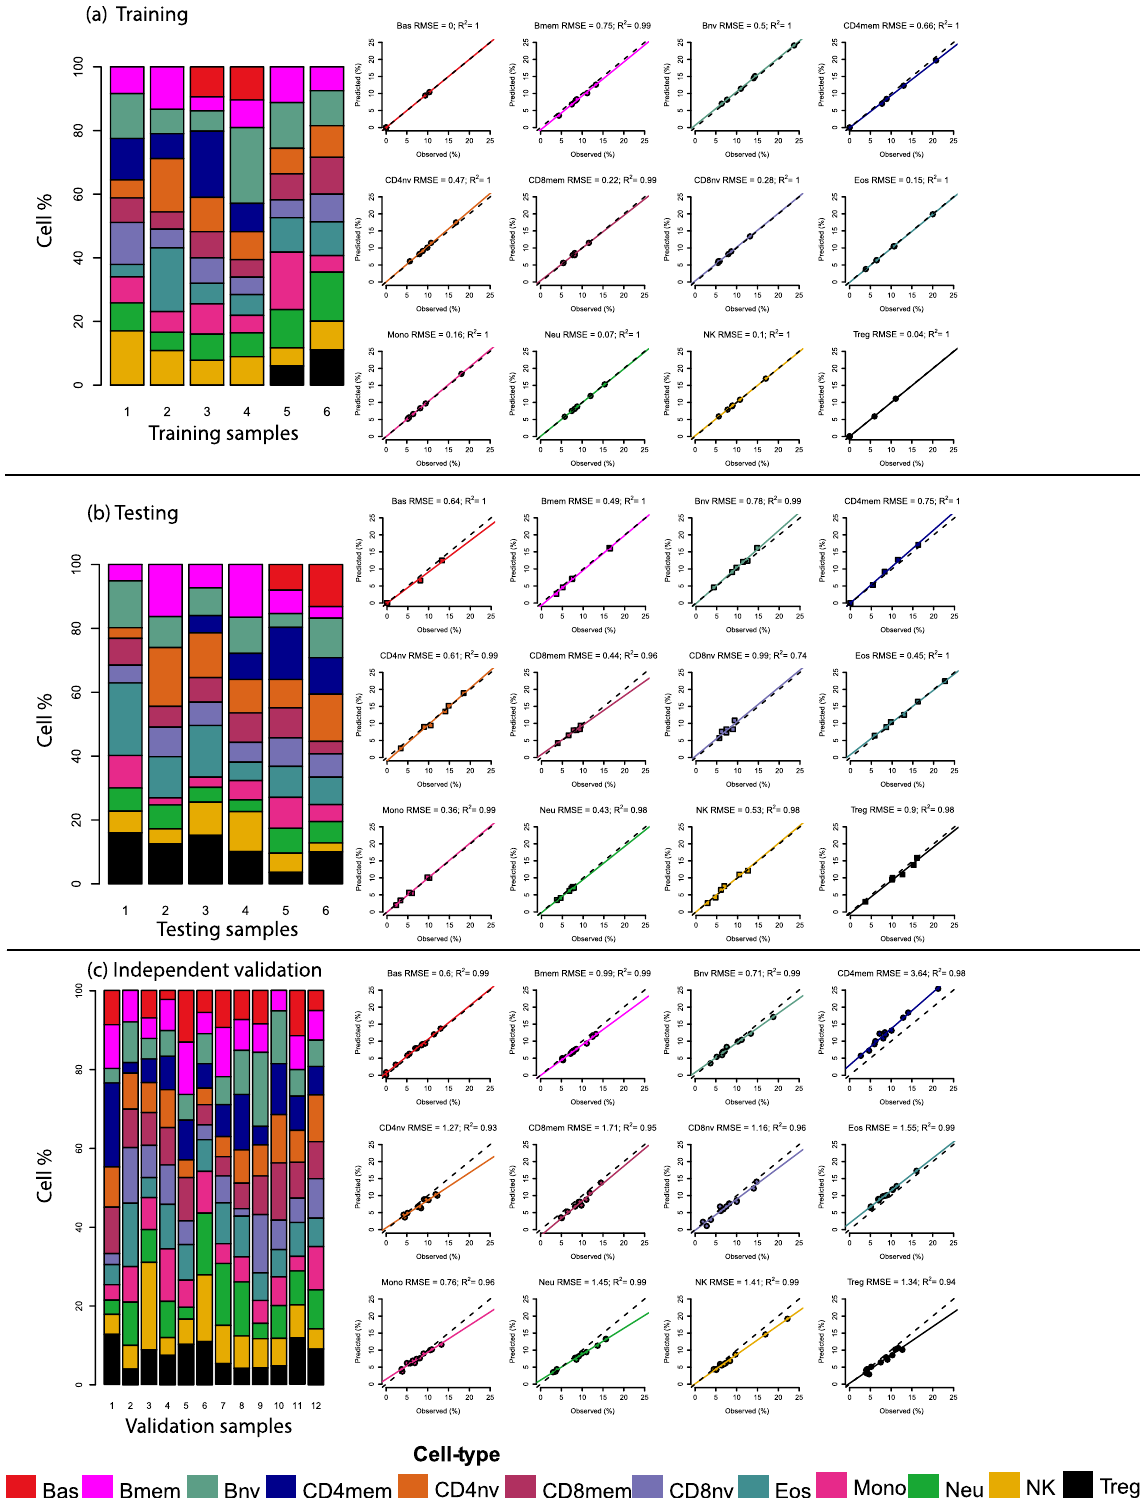
in the error estimations for CD4mem (RMSE = 3.64) with compensatory decreases in the Treg, CD4nv, and CD8mem compartments. Probes in the EPIC IDOL-Ext library tracked mostly to open sea regions of low CpG density (76%), followed by CpG